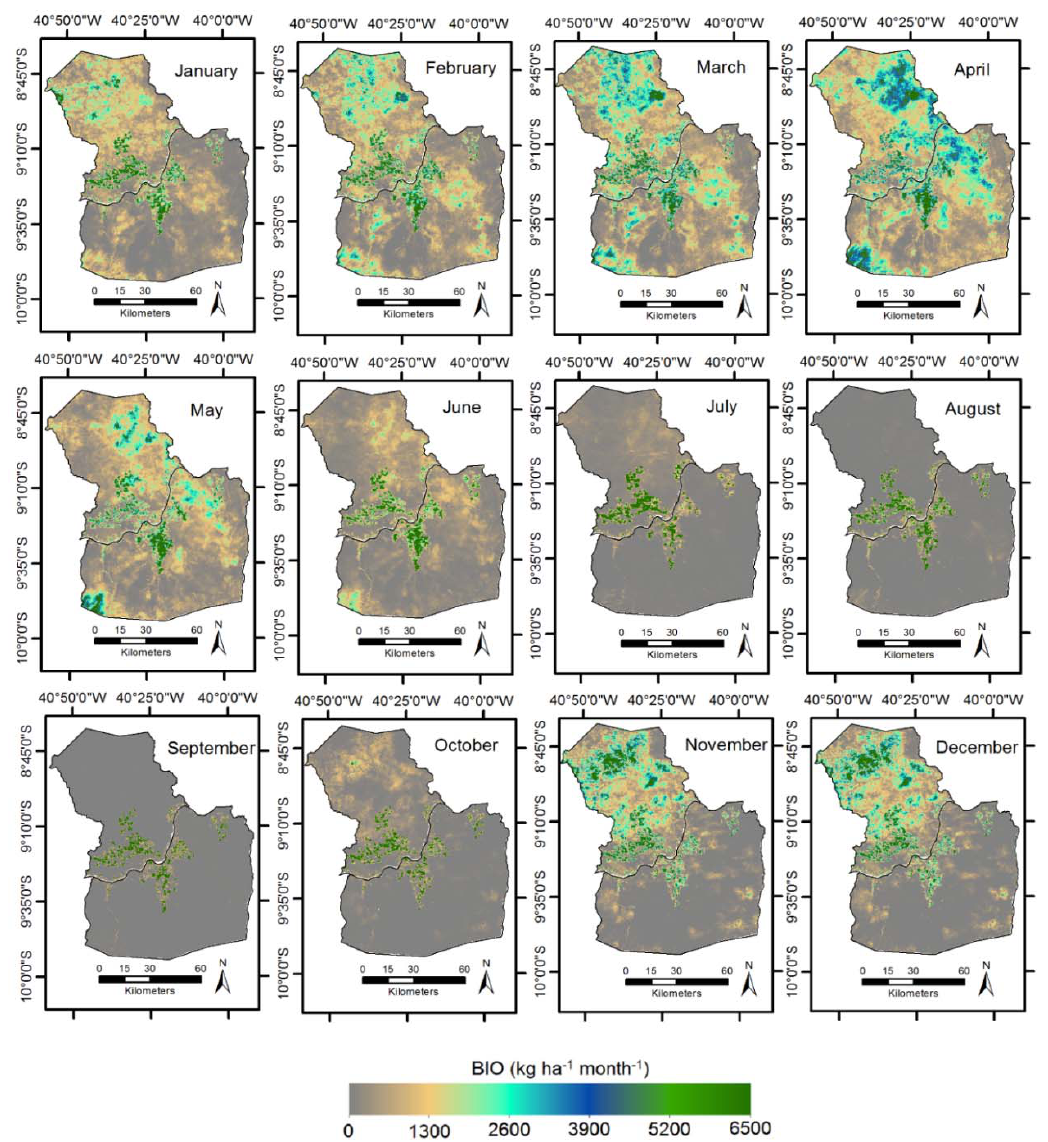
Figure 5. Spatial distribution of the monthly values of biomass production (BIO) for the mixed agro-ecosystems of Petrolina and Juazeiro municipalities, respectively Pernambuco (PE) and Bahia (BA) states, Brazil, during the year of